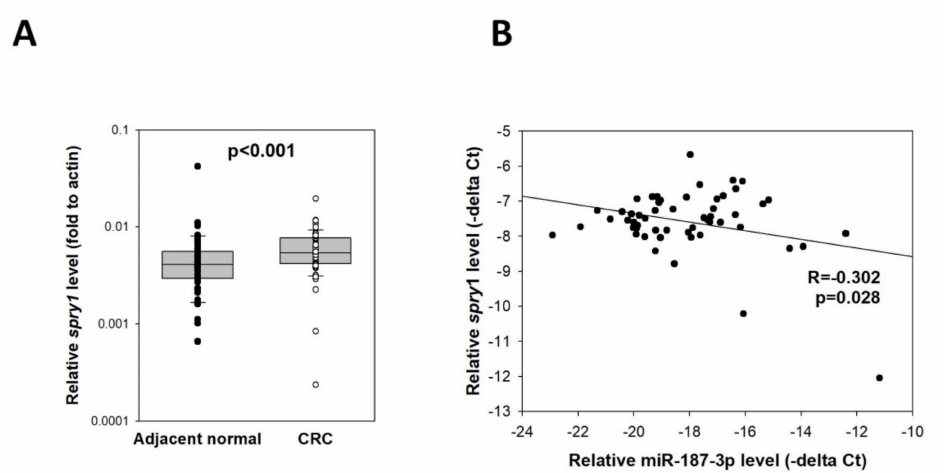
Figure 10. Expression of SPRY1 and its correlation with miR-187-3p in CRC tissues: ( A ) Quantitative RT-PCR was performed to determine the SPRY1 levels in 54 paired CRC specimens and adjacent normal mucosa. ( B ) Pearson’s correlation analysis in the CRC cohort showed that there was a significant inverse correlation between miR-187-3p and SPRY1 (R = − 0.302, p = 0.028). The levels of miR-187-3p were expressed as –delta Ct (miR-187-3p–U6), whereas levels of SPRY1 were expressed as –delta Ct ( spry1 - actin ). · and indicated the individual data points of adjacent normal tissues and (cid:35) CRC,